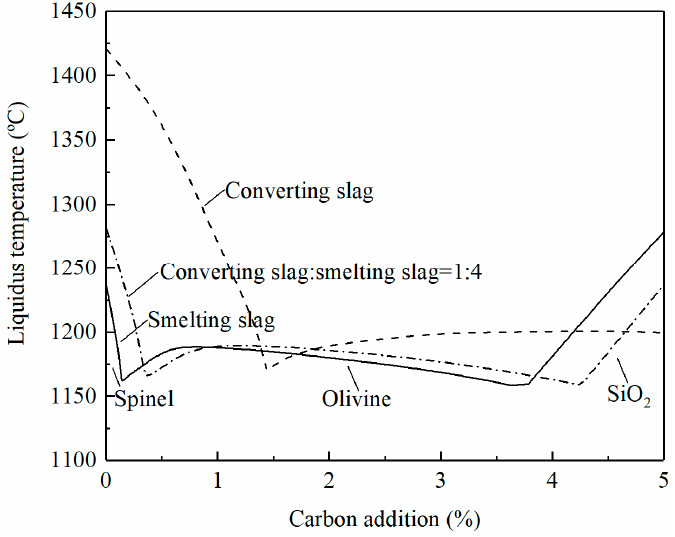
Figure 7. Effect of carbon addition on the liquidus temperature of slag, calculated by FactSage 8.2.